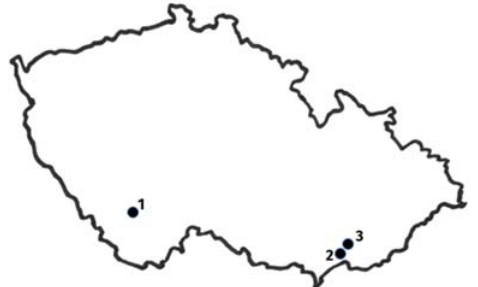
Figure 1. Localization of selected research site on the territory of the Czech Republic. The first experimental site was situated in the South Bohemian Region, the Prachatice district (Boubín forest enterprise Boubín, forest district of Netolice–1). The remaining two sites were in the South Moravian Region, Hodonín district (Management plan area (LHC) Strážnice, district of Ratíškovice–2; LHC Strážnice, district of Bzenec, Pískovna–3).